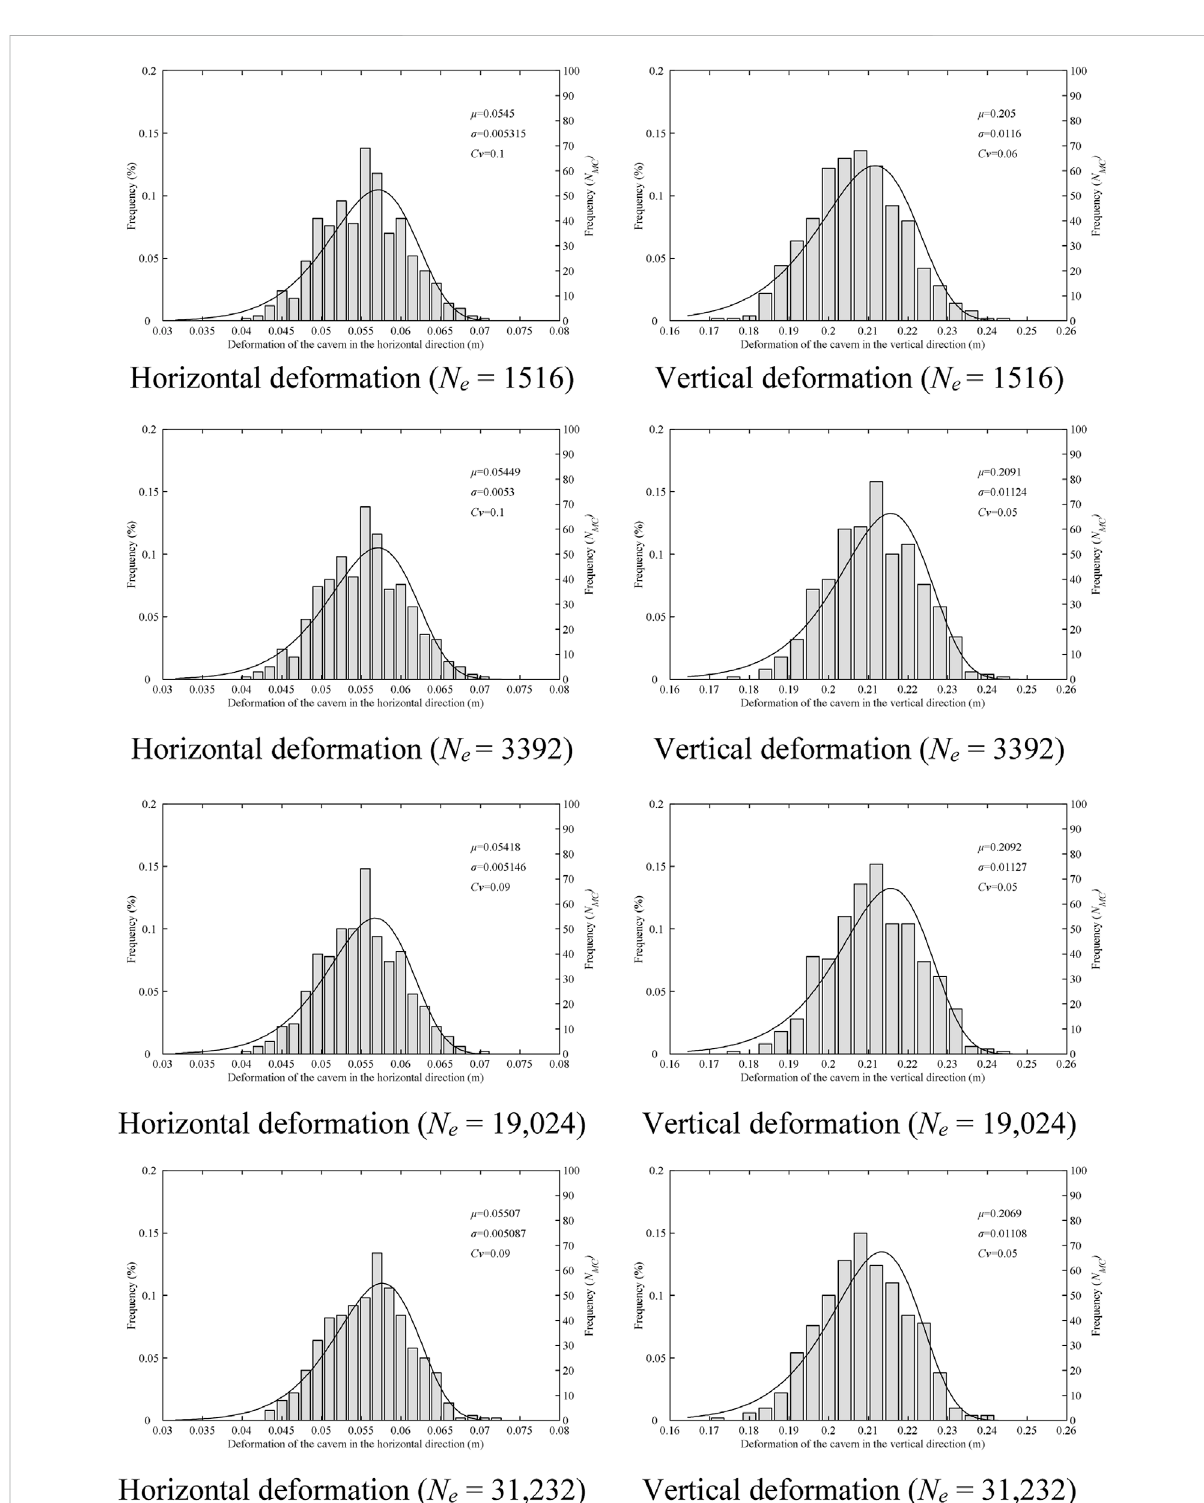
FIGURE 6 Distribution of calculation results using different numbers of elements. Horizontal deformation ( N e = 1516), Vertical deformation ( N e = 1516), Horizontal deformation ( N e = 3392), Vertical deformation ( N e = 3392), Horizontal deformation ( N e = 19,024), Vertical deformation ( N e = 19,024), Horizontal deformation ( N e = 31,232), Vertical deformation ( N e =